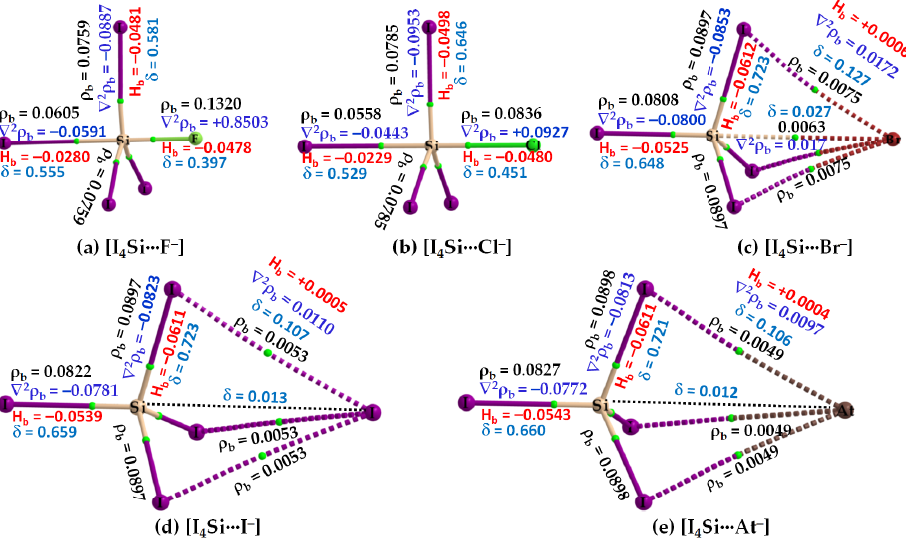
Figure 5. ( a – e ) [ωB97X -D/def2-QZVPPD] level QTIM-based molecular graphs of [I 4 Si ··· X − ] (X = F, Cl, Br, I, At), showing the bond paths (solid and dotted lines in atom color) and bond critical points (tiny spheres in green) between bonded atomic basins. Large spheres represent the atomic basins, with atoms labeled. The dotted black line in ( d , e ) is artificially drawn to represent the presence of tetrel bond between Si and X (X = I, At). The charge density ( ρ b ), the Laplacian of the charge density ( ∇ 2 ρ b ), the total energy density (H b ), and the delocalization index ( δ ) values are shown in black, blue, red, and faint-blue fonts (in a.u.),